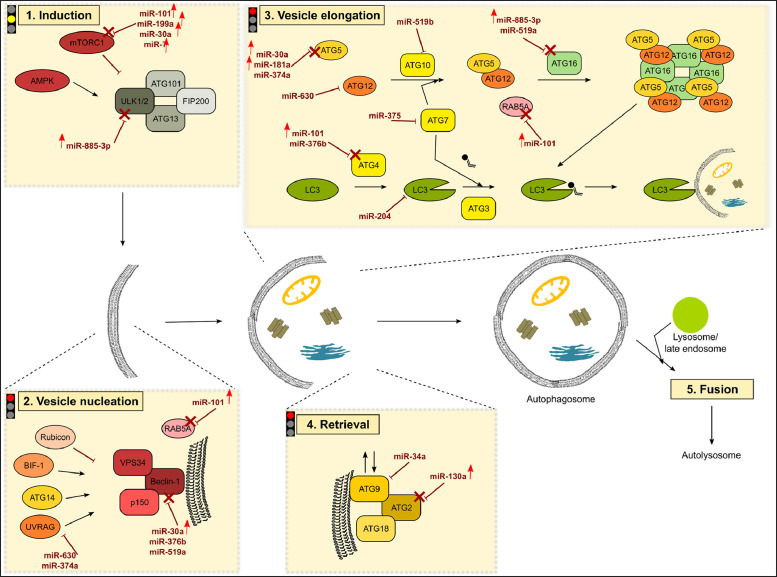
The core autophagic pathway and its regulation by miRNAs in THP-1 cells exposed to the lower dose of CdS QDs. The entire pathway was divided into five steps classified as induction, vesicle nucleation, elongation, retrieval and fusion. In the whole pathway, point and block arrows indicate activation or inhibition, respectively. In the experimental conditions, the arrows next to the miRNAs indicate an increase or decrease of the miRNA. A red arrow indicates an increase in a specific miRNA and its target repressed is indicated with a red cross. As a result, the specific step is locked (red light) or could be unlocked (yellow light). Under this condition, the autophagic pathway could not be activated.Note: DIANA-Tarbase database and DIANA-mirPath were used to obtain the data to create this chart.